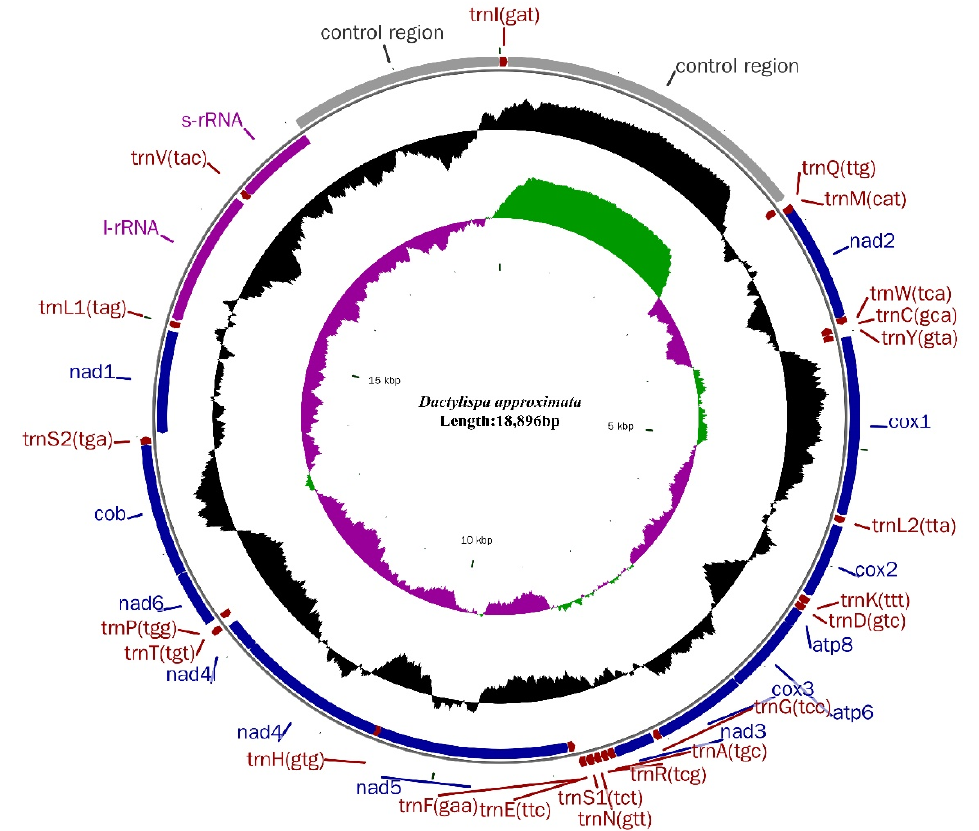
Figure 1. Circular diagram of the mitochondrial genome of Dactylispa approximata . Genes outside the circle are transcribed in a clockwise direction, whereas those inside the circle are transcribed counterclockwise. Protein ‐ coding genes (PCGs) are in blue, tRNA genes are in red, and rRNA genes are in purple. The second circle shows the GC content, and the third circle shows the GC skew. The GC content and GC skew are plotted as the deviation from the average value of the entire sequence. Circular diagrams of the mitogenomes of the other seven Dactylispa species are shown in Figure S1.